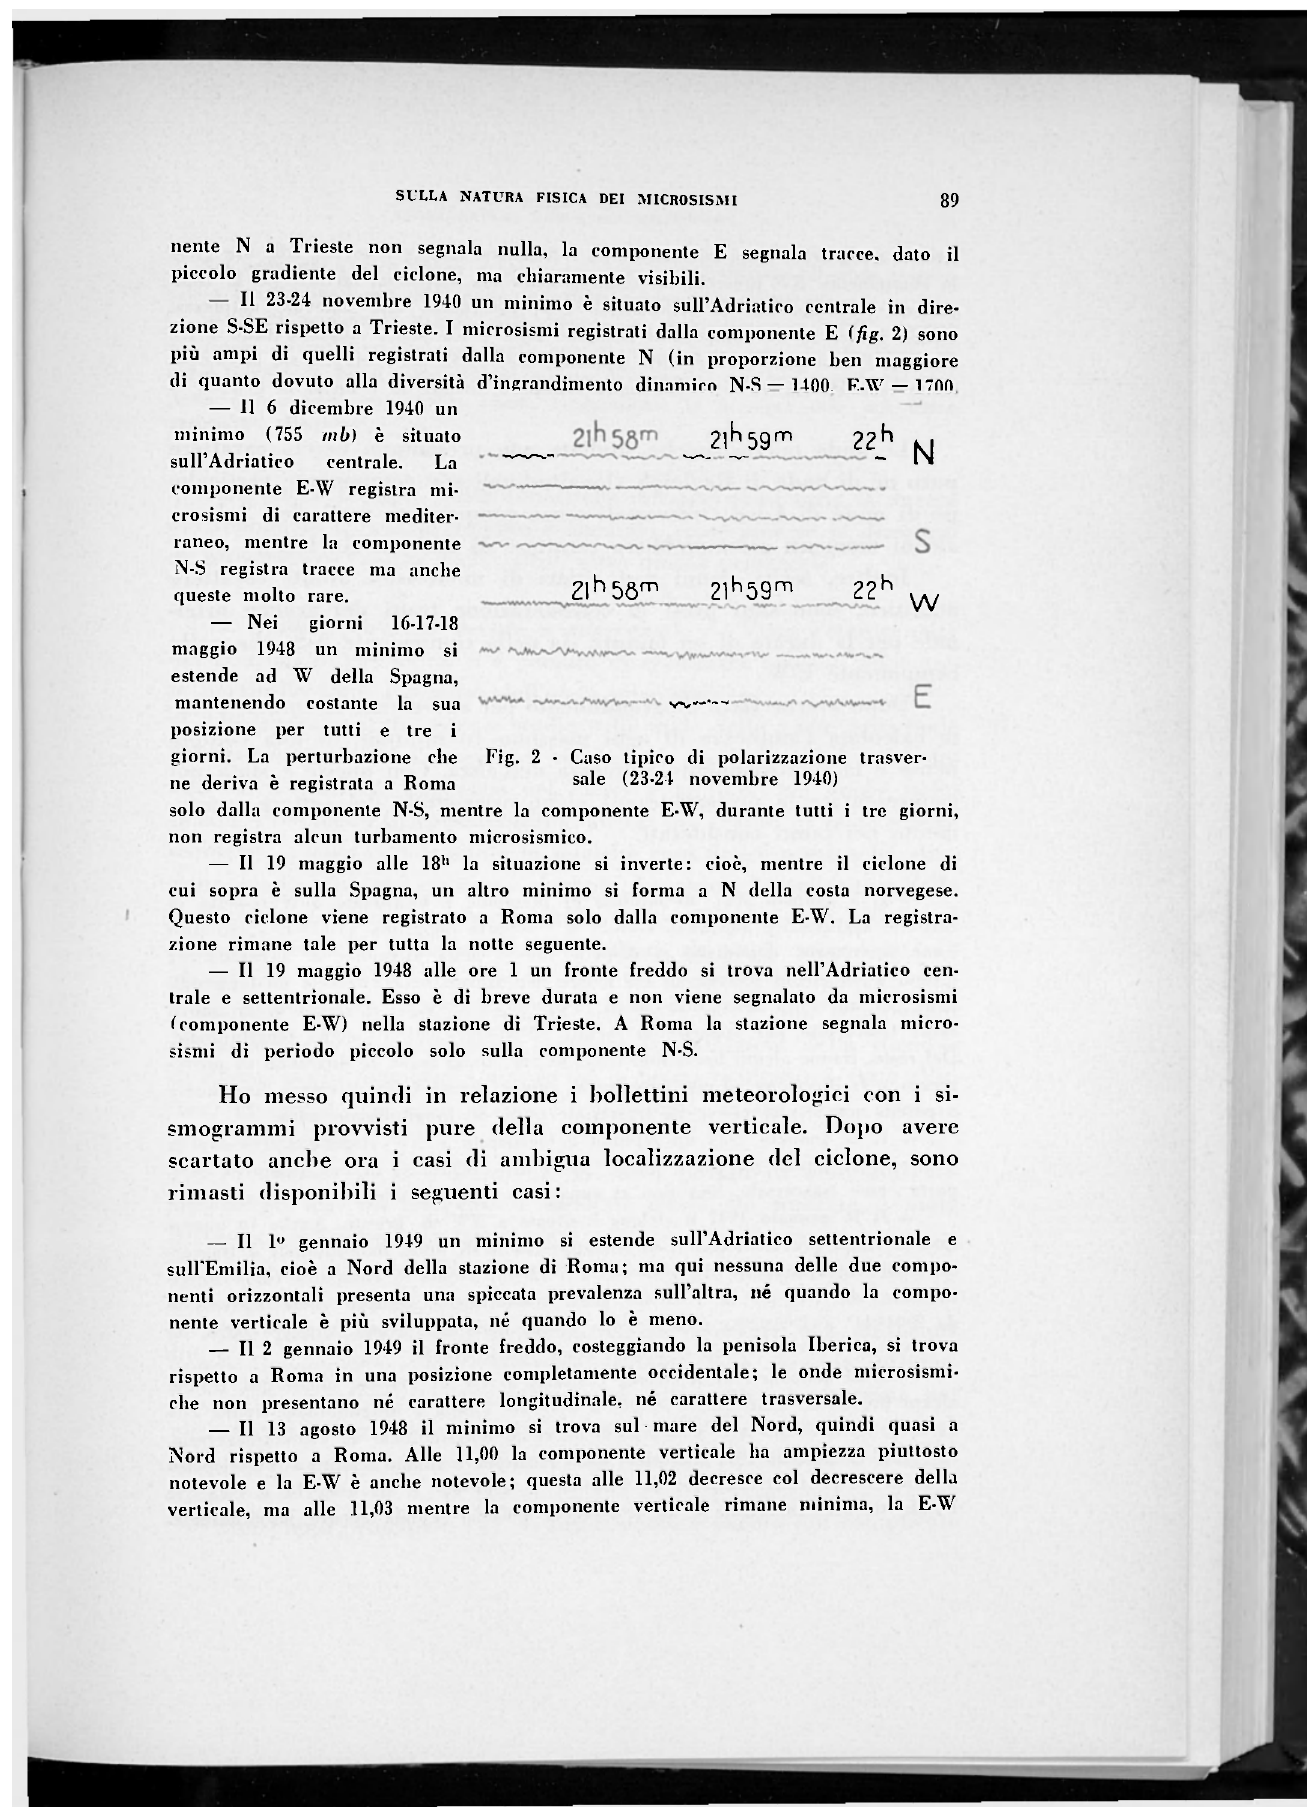
Fig. 2 - Caso tipico di polarizzazione trasver- sale (23-24 novembre